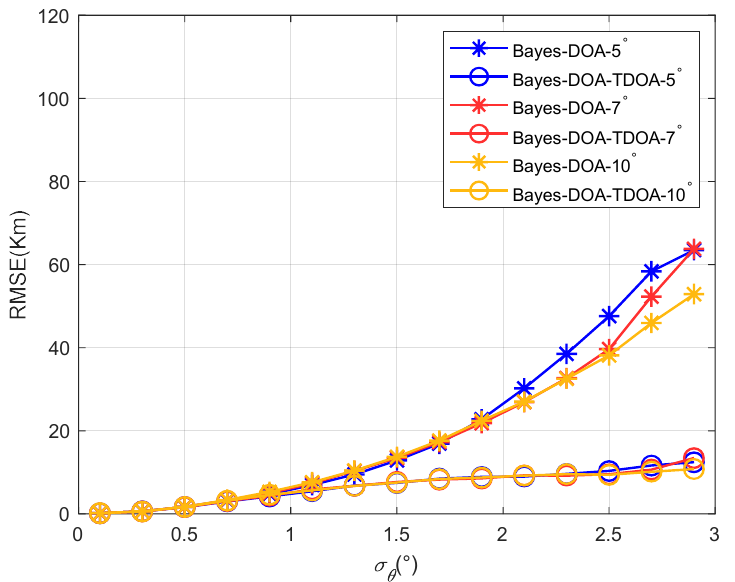
Figure 16. The positioning accuracy varied with the standard deviation of the angle’s error when the multipath elevation angles’ differences were 5°, 7°, and 10°.